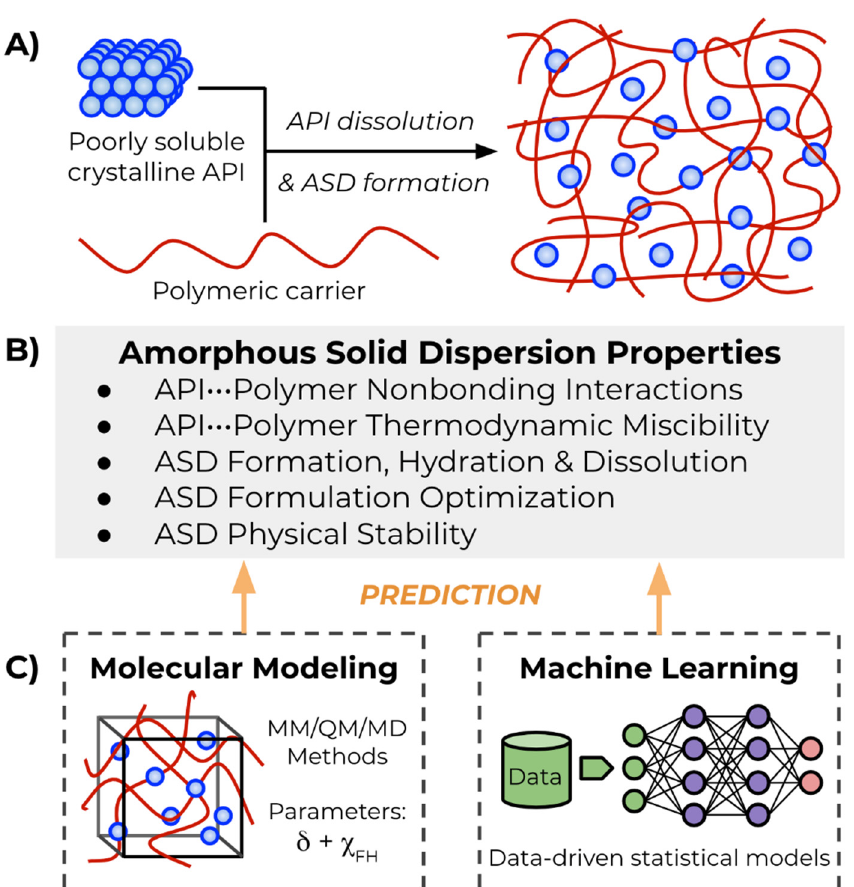
Figure 1. ( a ) Forming an ASD (amorphous solid dispersion) from mixing poorly water-soluble APIs (active pharmaceutical ingredients) with polymeric carriers. ( b ) General ASD properties and phenomena covered in this review. ( c ) Molecular modeling and machine learning are in silico methods for predicting ASD properties and phenomena. Miscibility estimated by calculation of solubility ( δ ) and Flory–Huggins interaction ( χ FH ) parameters.